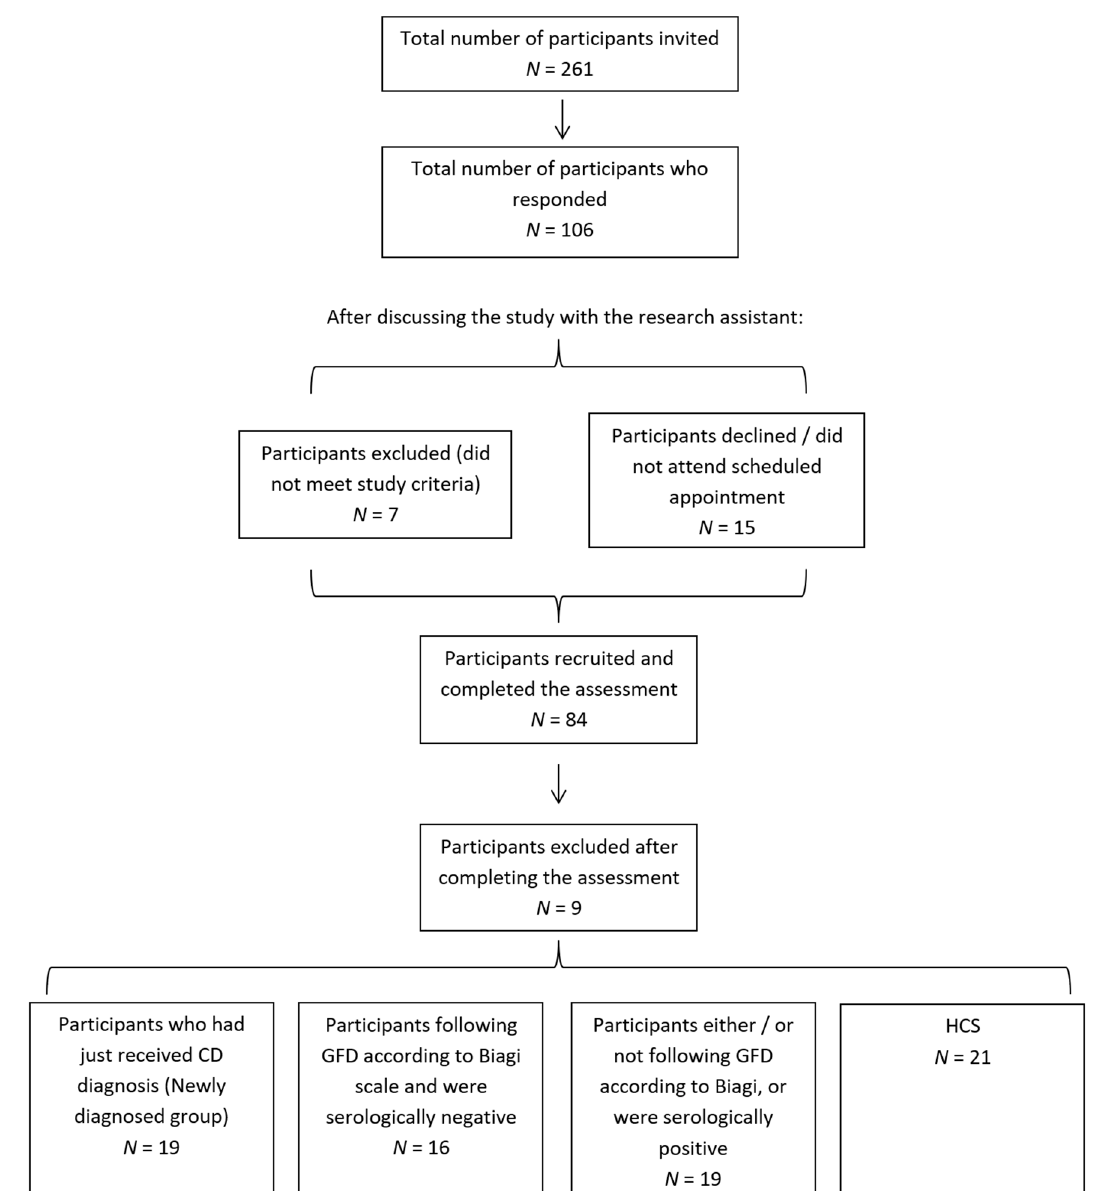
Figure 1. Participant recruitment process, including sample sizes. HCS, healthy control